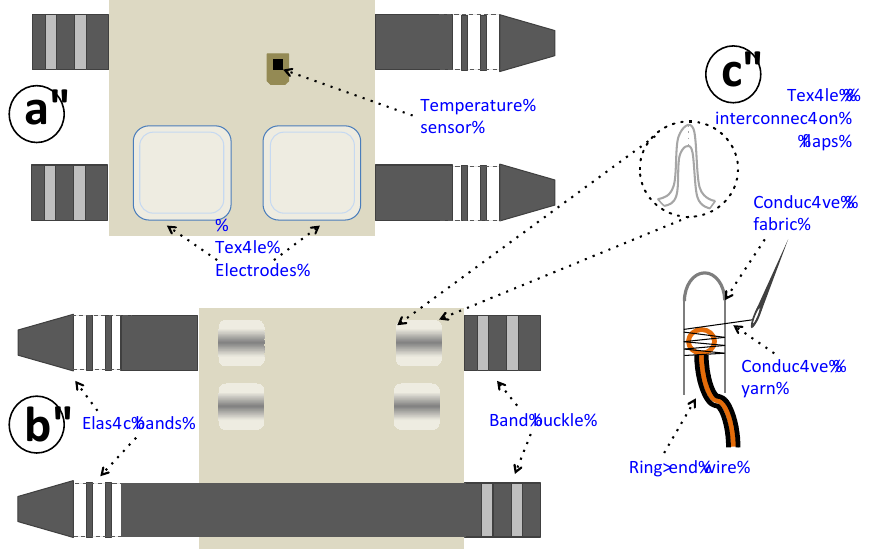
Figure 8. Schematic of the constructed sensorized upper arm strap. ( a ) Inside view showing the sensors. ( b ) Outside view where the sensing device has been placed and connected. ( c ) Detail of the textile-electronic interconnection, which is achieved by sewing conductive fabric through a ring-shaped end using conductive yarn.